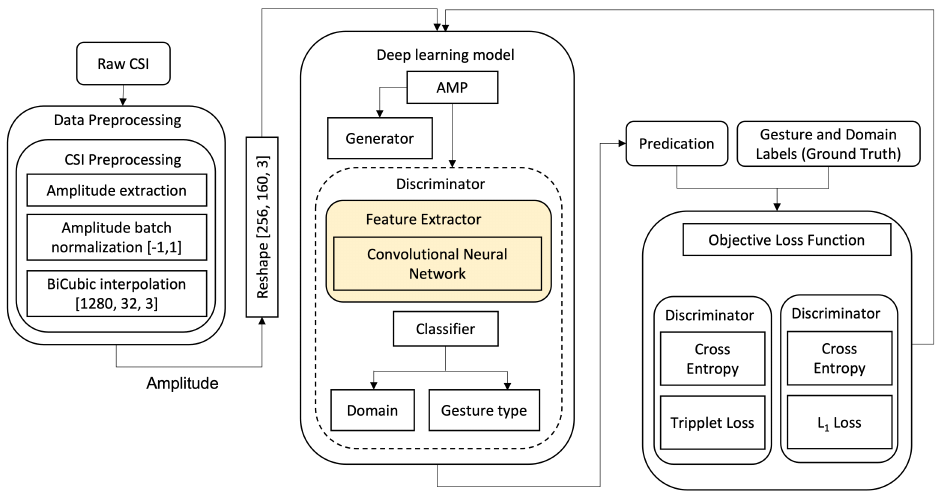
Figure 3. Our proposed generative adversarial network-based pipeline